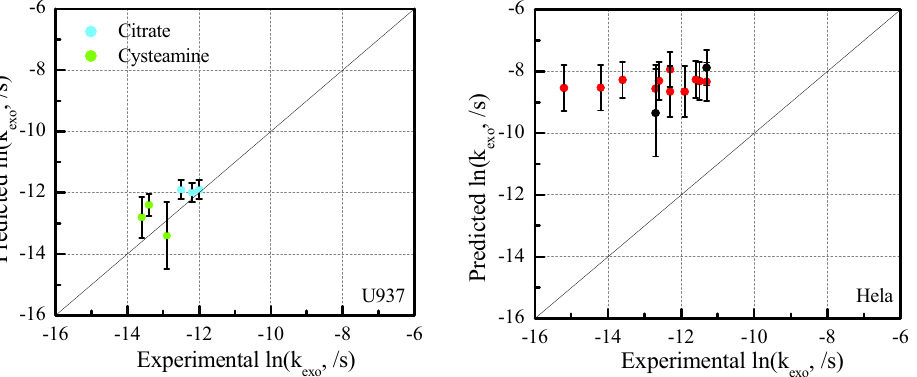
Figure 3. Plot of ln( k exo , /s) predicted by U937 and Hela models (Fig. 2) vs. experimental ln( k exo , /s): six ln( k exo , /s) based on experimental exocytosis curves of charged NPs were denoted as ‘green circle or blue circle’ (three are cationic and three are anionic 44 ) for U937 cells and 14 ln( k exo , /s) of neutral NPs 28,43 based solely on initial and final intracellular NP concentrations for Hela cells were denoted as ‘red circle’. The 95% confidence intervals for the predicted results are also represented by different